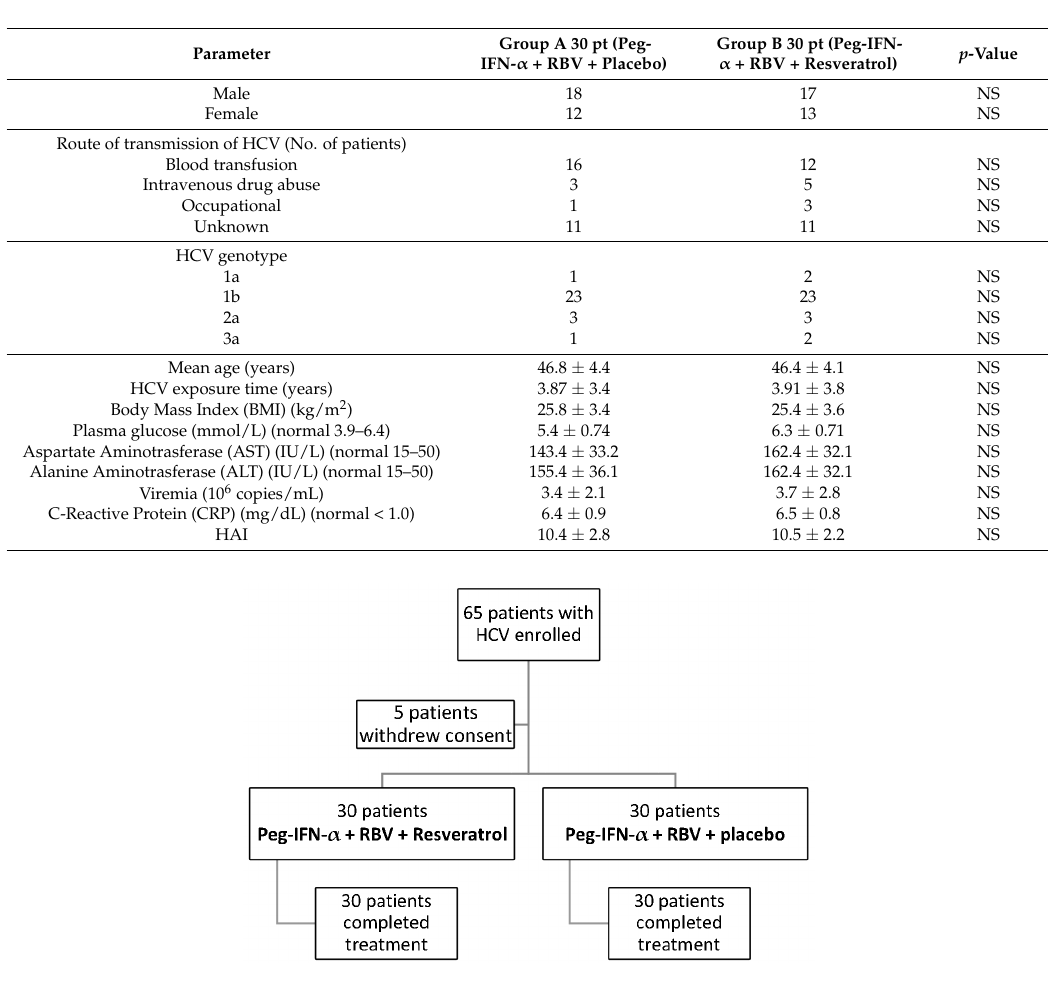
Figure 1. Profile of Peg-IFN α 2b, RBV and Resveratrol treatment.